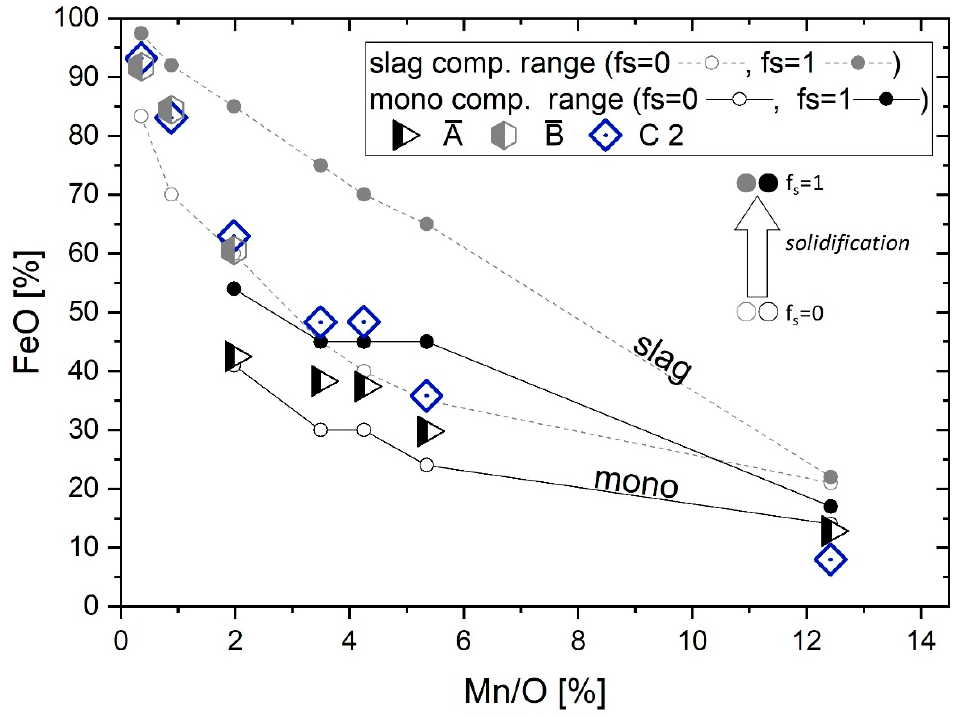
Figure 8. Comparison of thermodynamic results with measured particle compositions.